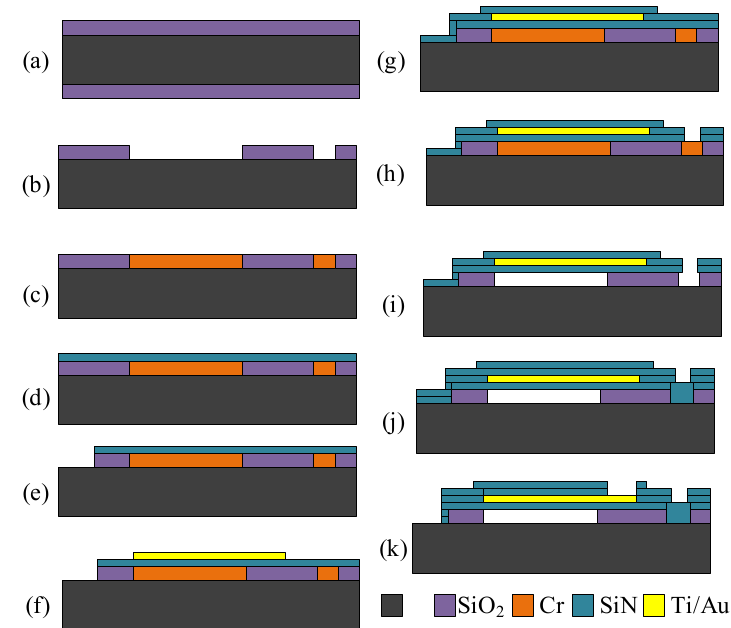
Figure 4. Sacrificial release CMUT device fabrication steps: ( a ) thermal oxidation, ( b ) cavity formation, ( c ) sacrificial layer deposition (Cr), ( d ) membrane formation using silicon nitride PECVD deposition, ( e ) ground electrode openings, ( f ) top electrode formation, lift-off manufacturing step, ( g ) passivation with PECVD SiN, ( h ) etch hole formation, ( i ) etching of the sacrificial layer, ( j ) closing etch holes with PECVD SiN, and ( k ) revealing top and bottom electrodes.